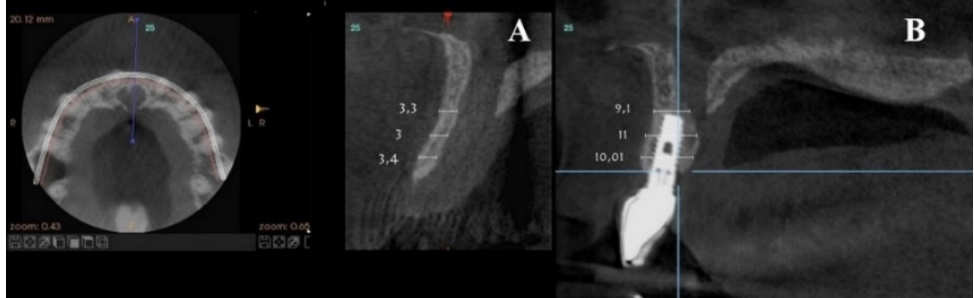
Figure 10. Radiographic control of Patient 1 at their 9-year follow-up. An occlusal view is shown on the left. ( A ) Sagittal view of the nasopalatine duct prior to treatment. ( B ) Post-treatment control